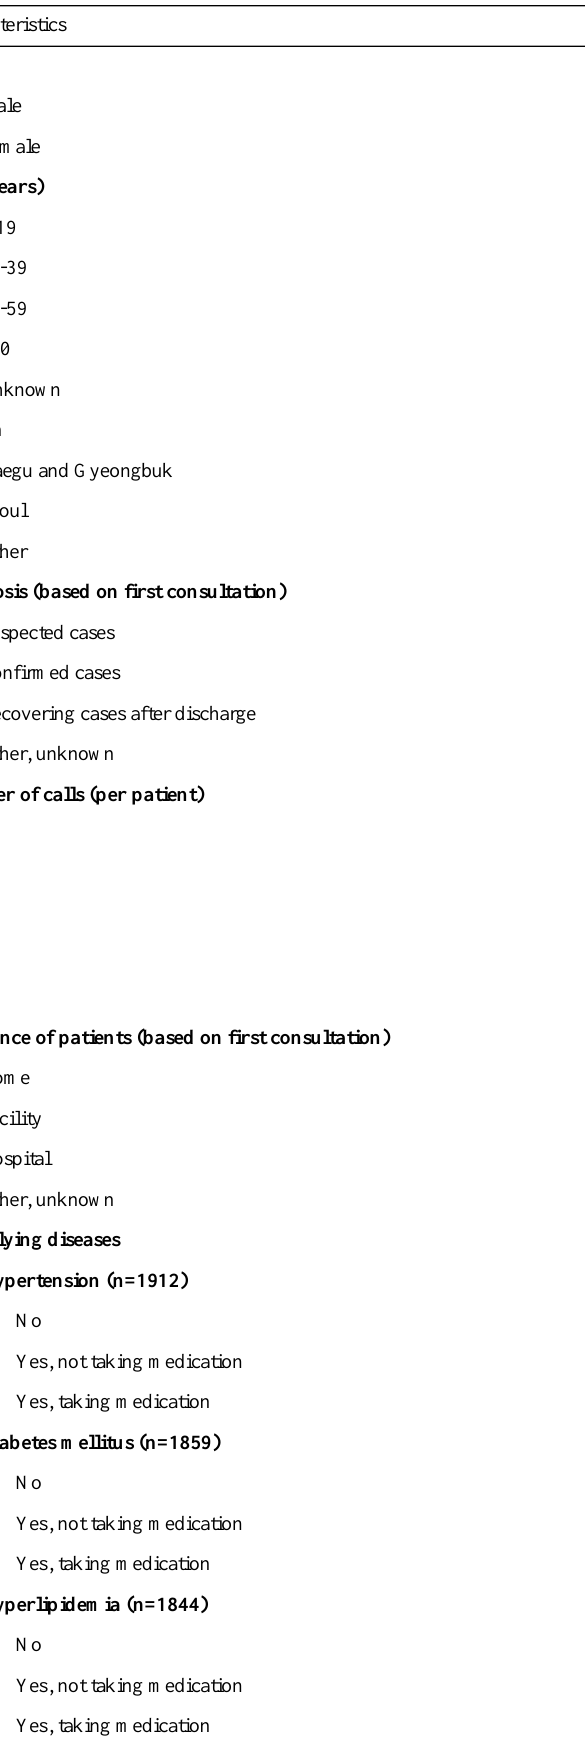
Table 1. Characteristics of patients enrolled in the Korean Medicine telemedicine program for COVID-19